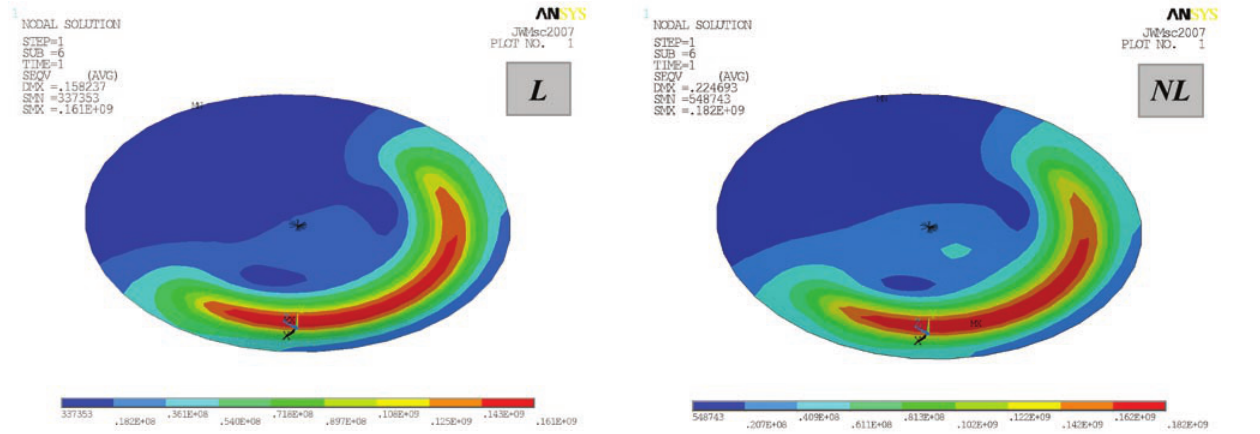
Fig. 13. Stress intensity contours according to von Mises in the plate f H-M , L ( σ ) ∈ [0.337; 161.0], MPa